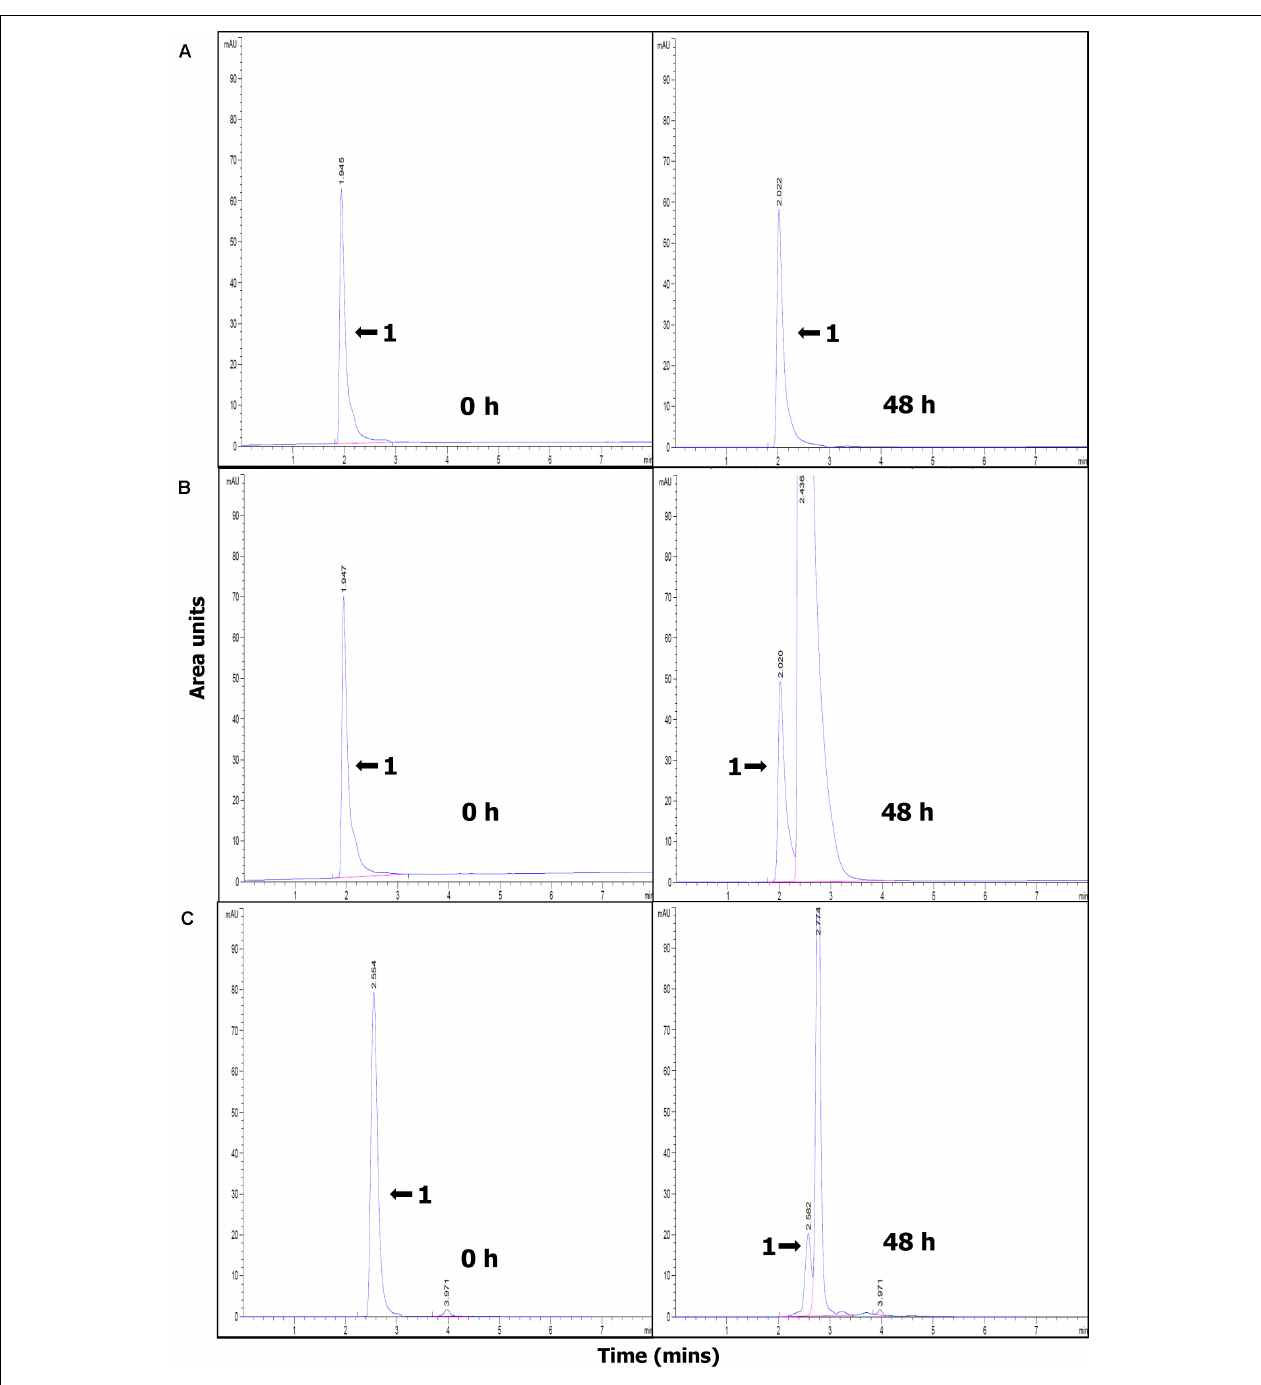
FIGURE 5 | HPLC chromatogram showing paraquat degradation at 0 and 48 h. (A) DW (control), (B) LA-Low-BioMnO x -H 2 O 2 , and (C) LA-High-BioMnO x -H 2 O 2 (the arrow with the number 1 indicates the peak representing paraquat). DW, deionized water; LA-Low-BioMnO x -H 2 O 2 , living microalga with low BioMnO x plus H 2 O 2 ; LA-High-BioMnO x , living microalga with high BioMnO x plus H 2 O 2